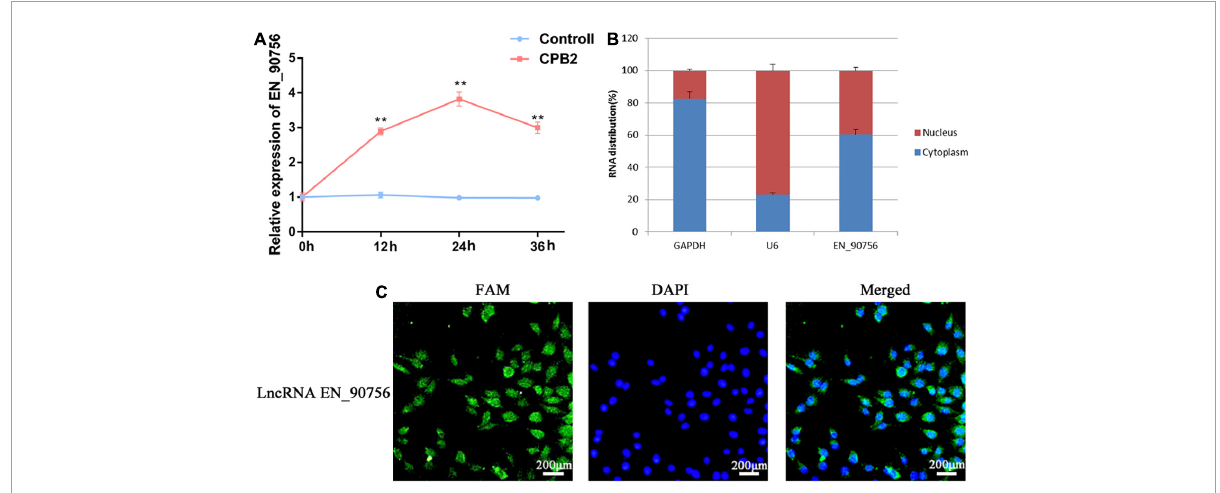
FIGURE3 Clostridium perfringens beta2 (CPB2) toxin induction promotes high expression of long non-coding RNA (lncRNA) EN-90756 in intestinal porcine epithelial cell line-J2 (IPEC-J2) cells. (A) Changes in lncRNA EN-90756 expression from 0 to 36 h in IPEC-J2 cells treated with 20 µ g/ml CPB2. (B) Nuclear/cytoplasmic isolation showed the distribution of lncRNA EN-90756 in the cells. (C) Fluorescent in situ hybridization (FISH) analysis of IPEC-J2 cells treated with CPB2 for 24 h using a FAM-labeled lncRNA EN-9075 probe (green) and 4 (cid:48) , 6-diamidino-2-phenylindole nuclear staining (blue). Scale bar = 200 µ m. ** p <